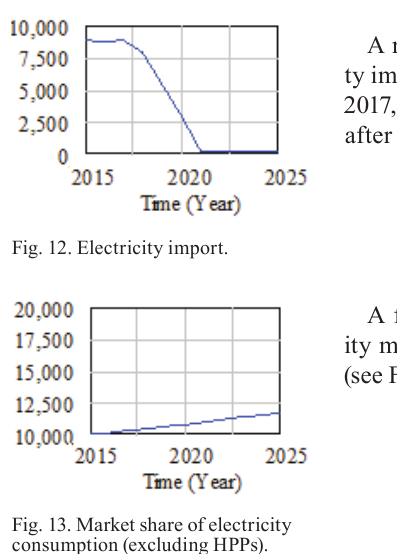
Fig. 13. Market share of electricity consumption (excluding HPPs).